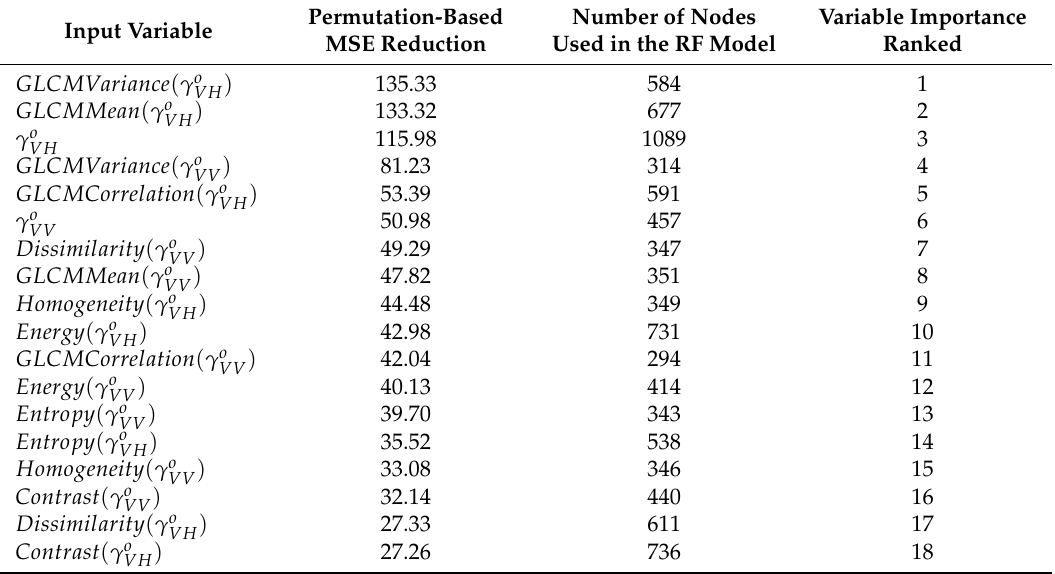
Table 1. Importance of the input variables using the Random Forests (RF) measured by the average impurity decreased. MSE: mean squared